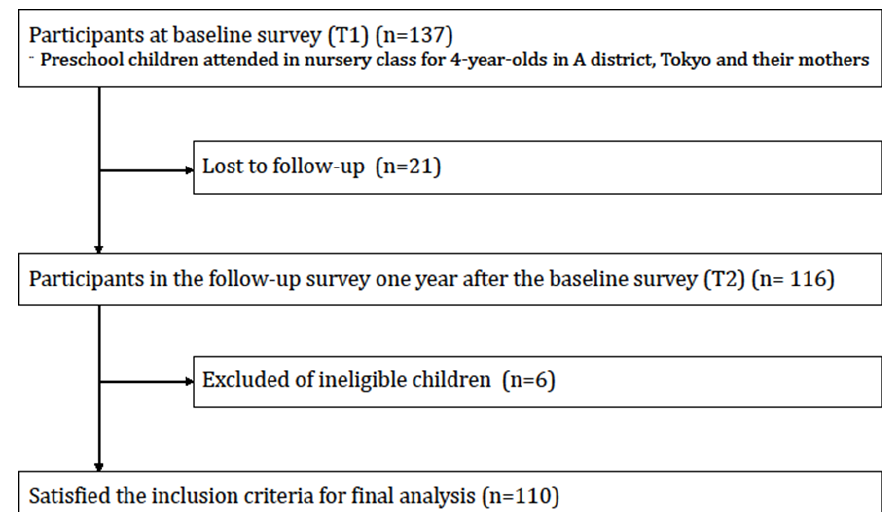
Figure 1. Participants flow chart for analytic sample.